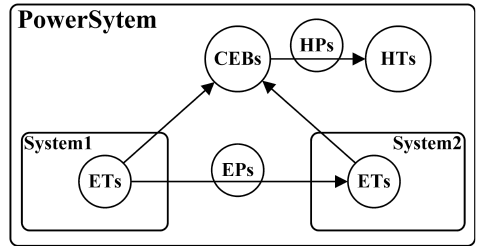
Figure 4. The relationship between constituent parts of an AADL